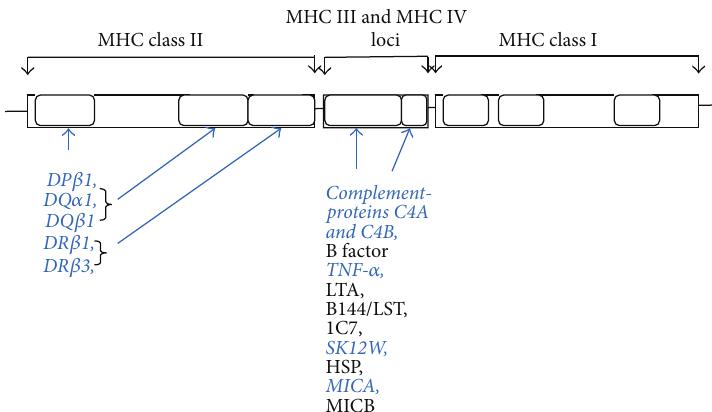
Figure 1: Major histocompatibility complex loci associated with type 1 diabetes. The known loci and products participating in the triggering of type 1 diabetes are marked in blue and italics. Table 2: The major histocompatibility complex and the human leukocyte antigens ∗ . Combinations HLA loci